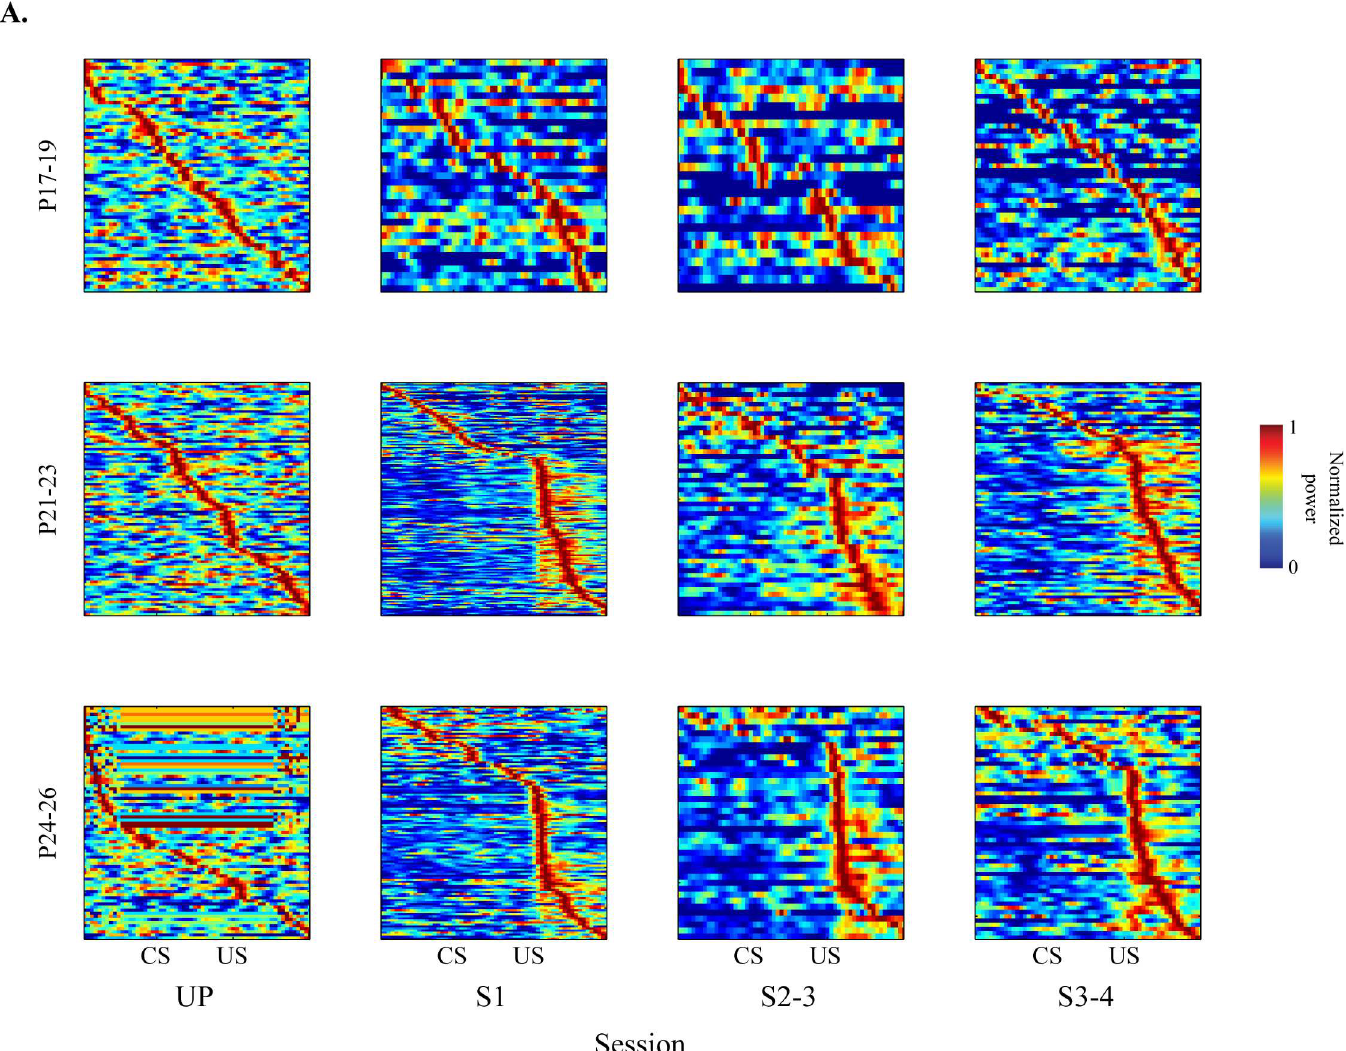
Fig 4. Population maps of CA1 firing. Population PETH maps across the sessions for rat pups given eyeblink conditioning on postnatal days (P) 17–19, P21-23 or P24-26. Population PETH maps were constructed by sorting the neurons by peak firing time positionsto show the distributionof the maximal neuronalfiring in each session and age group. For visualization, the firing rate for each neuron was individuallynormalizedand scaled from 0 to 1. Neurons recorded from the P17-19 group showed linearly alignedpatterns of peak firing across the sessions indicatingthat the neuronsdid not show specific event-related firing. However, both P21-23 and P24-26 groups showed upwardly curved patterns of peak neuronalfiring during paired sessions indicatingthat maximal firing rates were highly concentrated in the post-US